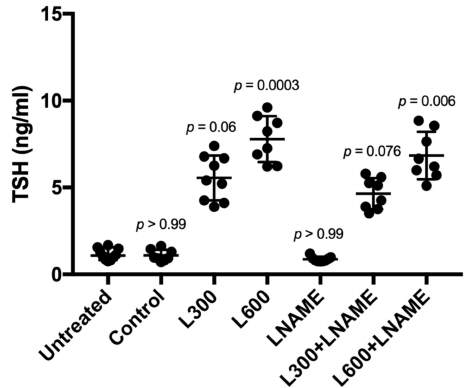
Figure 3. Thyroid-stimulating hormone (TSH). Fourteen days following orthodontic tooth movement, trunk blood was collected for serum preparation. Prepared serum was stored at − 70 ◦ C until measured by radioimmunoassay. Multiple comparisons were based on Kruskal–Wallis test and Dunn‘s correction. p -values show the changes compared to the normal non-OTM group. Comparison of L300/L600 with L300/L600 + LNAME are all p > 0.99 and thus not shown in Figure 3. Data are shown as dot blot with median and 95%